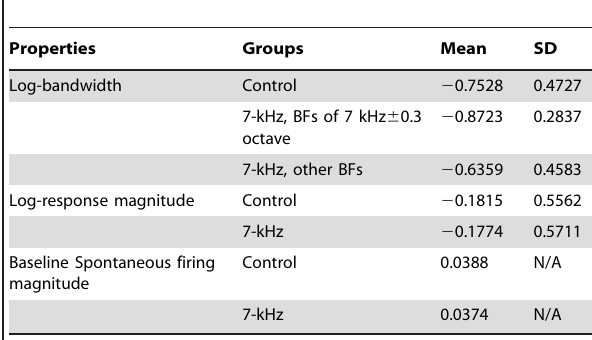
Table 1. Distribution parameters of neuronal response